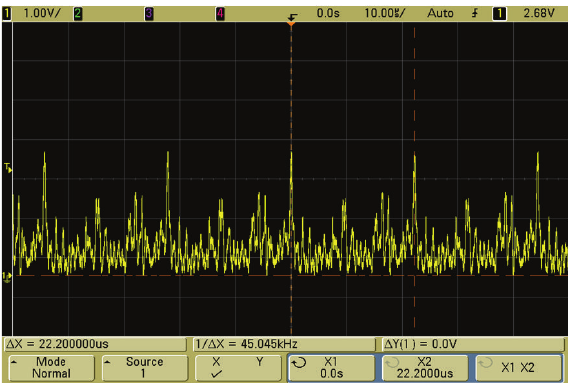
Figure 10: For 10 𝜇 s frequency, 4th degree Chi-square power distribution.